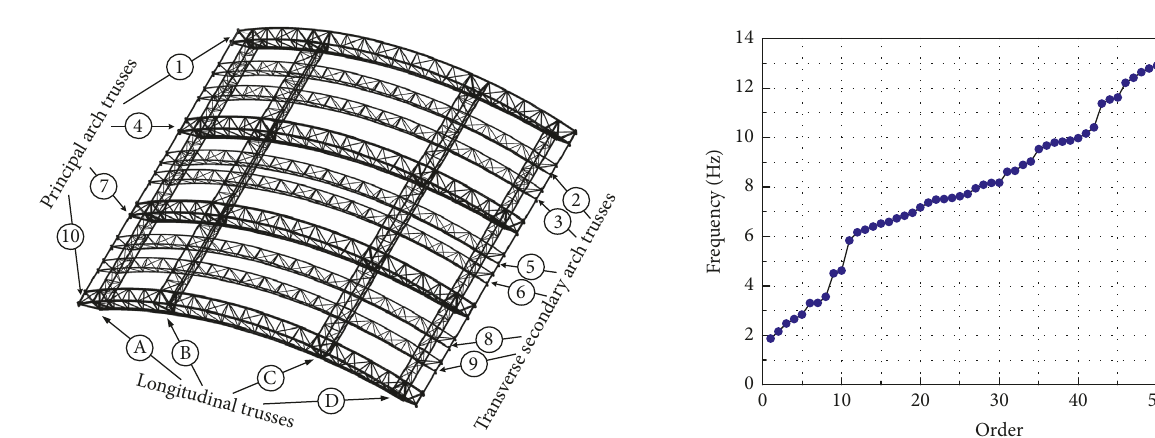
Figure 11: Overall FEM of the structure. Figure 12: The first sixty frequencies.